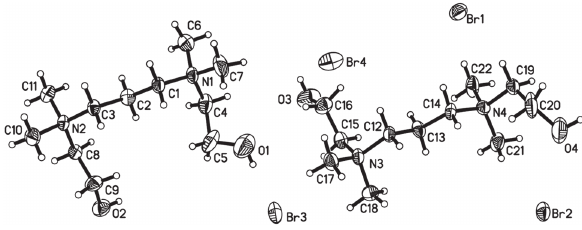
Table 1: Data collection and